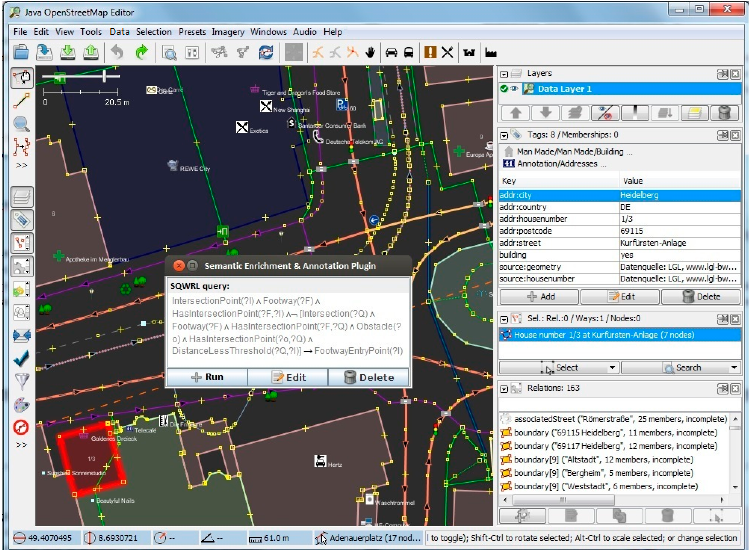
Figure 10. Enriched Semantic Query-Enhanced Web Rule Language (SQWRL) query to derive building entrances.